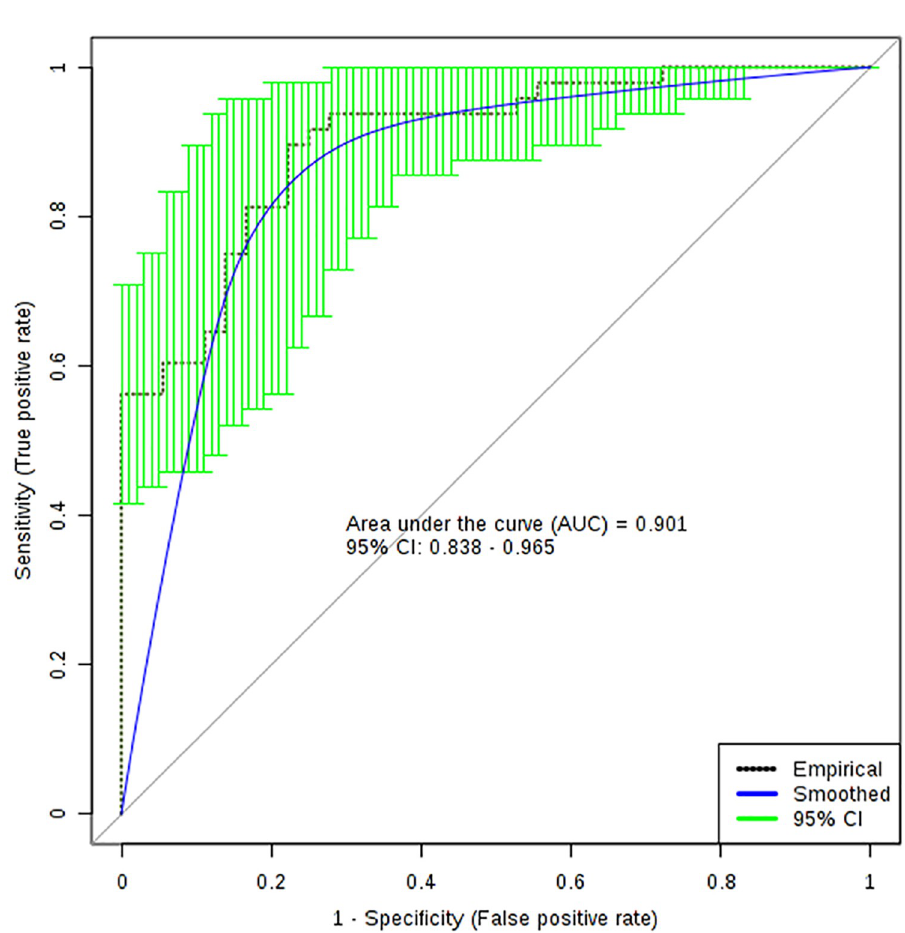
Fig 2. ROC curve performance using the oral microbiome. Empirical ROC performance during cross-validation and its 95 th percentile confidence interval are shown. Overall accuracy was 84.5%.